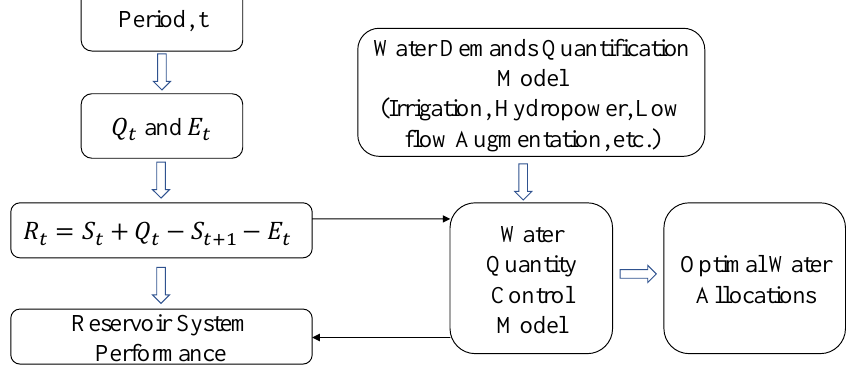
Figure 2. Water quantity control model of a reservoir.